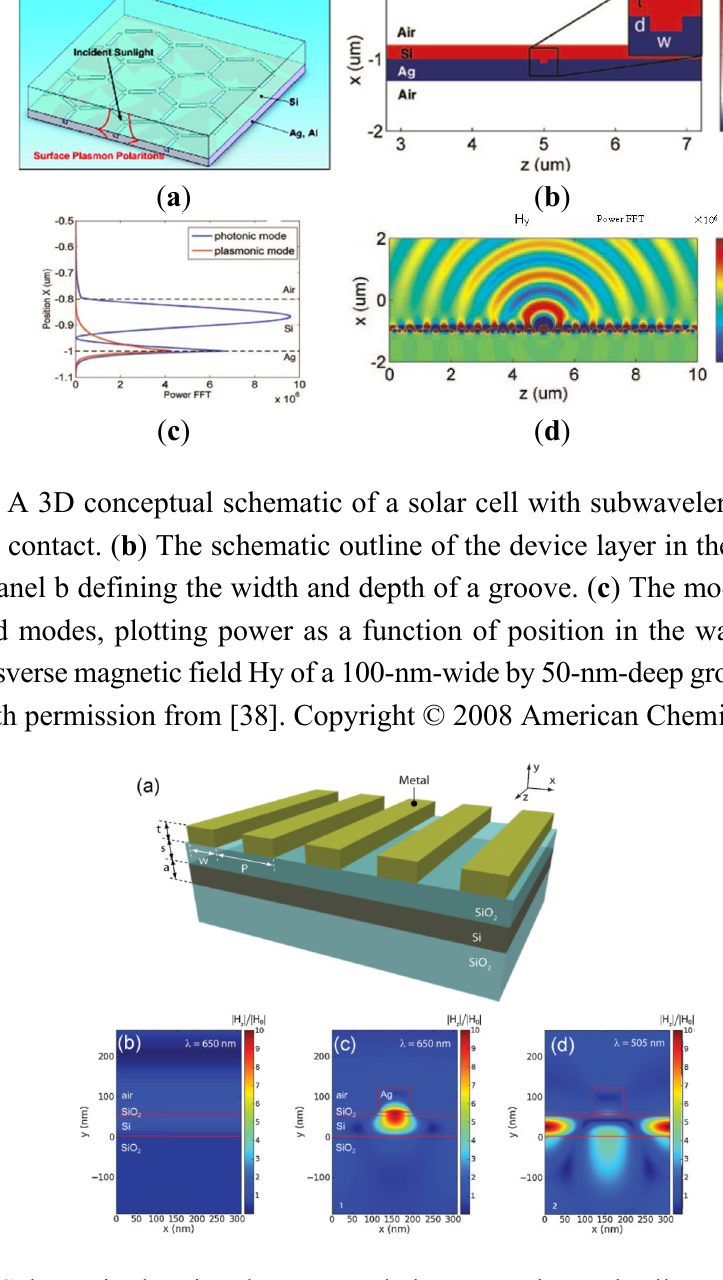
Figure 4. ( a ) Schematic showing the proposed plasmon-enhanced cell structure. Normalized and time-averaged field intensity plots for normal incidence. ( b ) TM illumination of a bare Si/SiO 2 structure, and ( c , d ) The same structure with a periodic array of metal strips spaced at p = 312 nm, a spacer layer thickness of s = 10 nm, and an absorbing Si film thickness, a = 50 nm. The incoming wavelengths (energies), λ = 650 nm (1.91 eV) for panels b and c, and λ = 505 nm (2.46 eV) for panel d, which were chosen to demonstrate the effects of strong near-field light concentration or excitation of waveguide modes by the strips. Reprinted with permission from [39]. Copyright © 2009 WILEY-VCH Verlag GmbH & Co. KGaA,